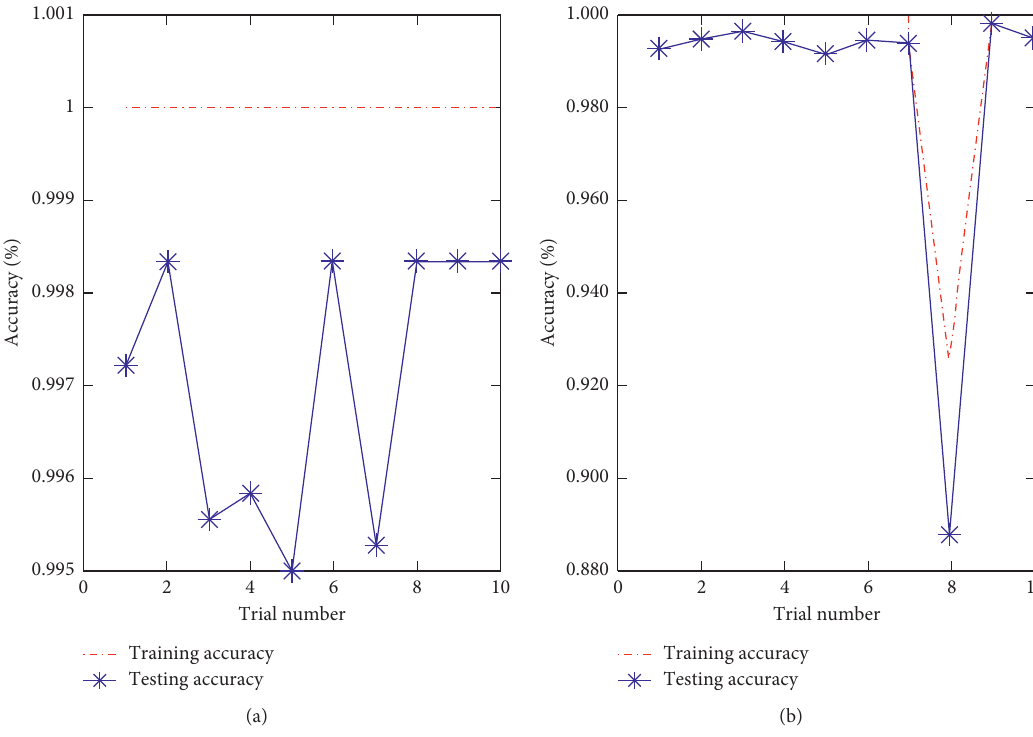
Figure 2: Diagnosis results of 10 trials of bearing datasets: (a) DCWT-SSAE; (b)